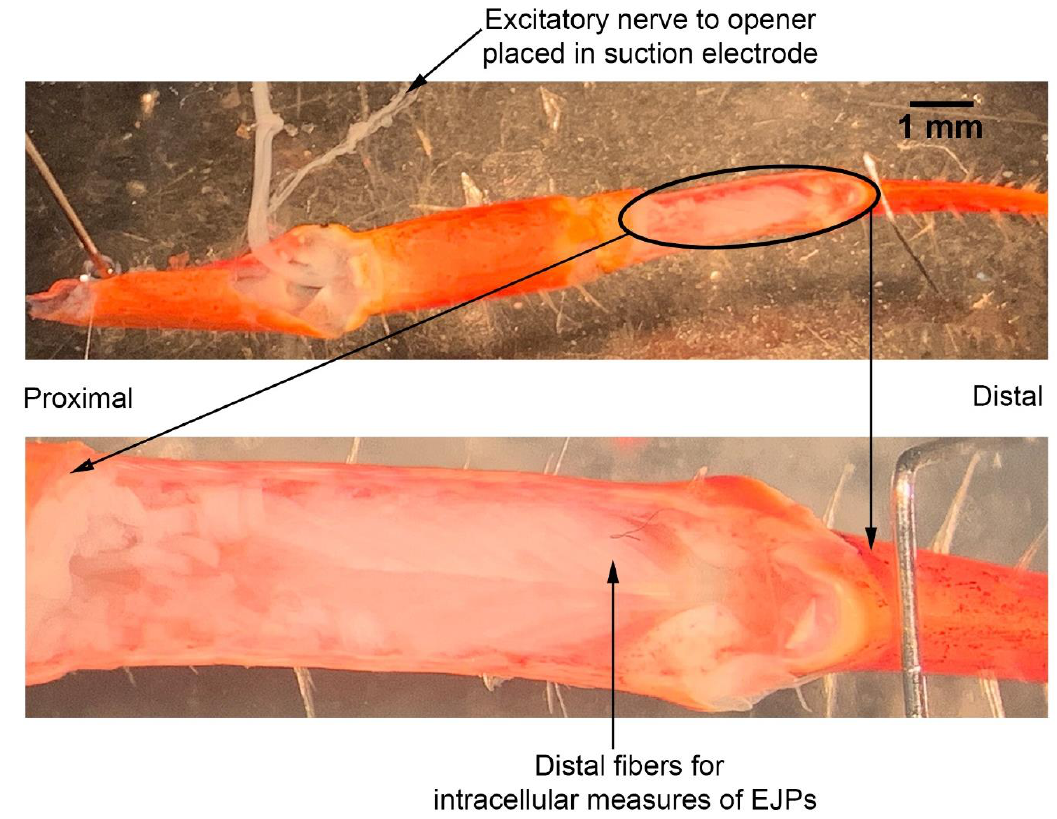
Figure 4. Opener muscle preparation. ( A ) A view of the crayfish walking leg opener muscle and excitatory axon bundle for the muscle. ( B ) The muscle excitatory junction potentials were recorded from the distal muscles of the preparation.